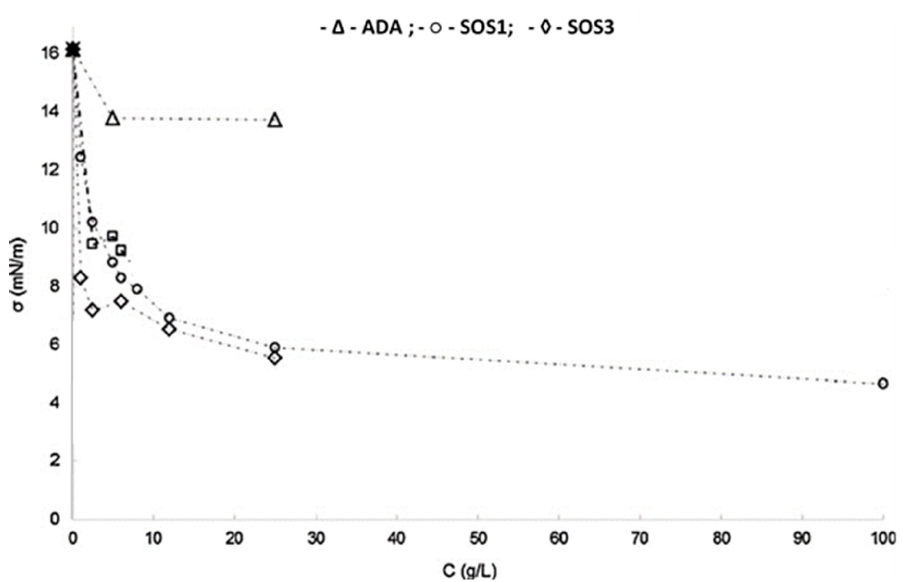
Figure 2. Reduction in interfacial tension between water and rosemary essential oil with the addition of ADA (- Δ -), SOS1 (-o-), and SOS3 (- ◊ -) (adapted with permission from